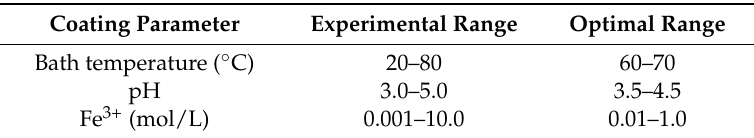
Table 1. Experimental conditions of electroless plating.